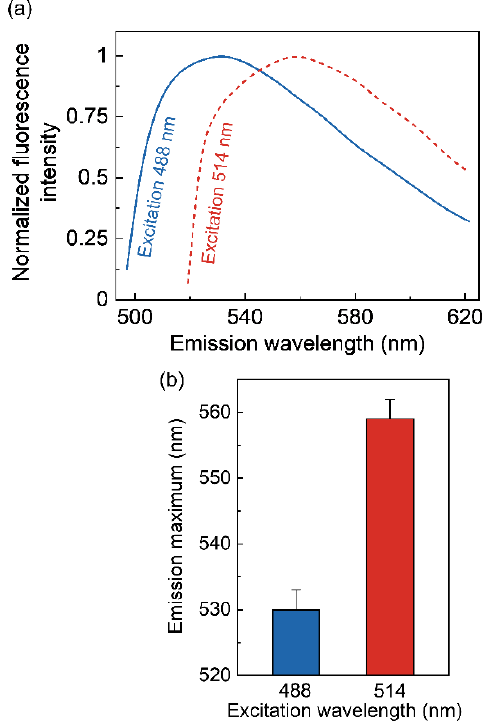
Figure 7. ( a ) Representative fluorescence emission spectra of NBD-serotonin analog I bound to the serotonin 1A receptor expressed in CHO-K1 cells at different excitation wavelengths. The excitation wavelengths were 488 (—) and 514 (- - -) nm. All spectra are intensity-normalized at the emission maximum. The concentration of NBD-serotonin analog I was 7 μM. A Zeiss LSM 880 inverted spectral imaging confocal microscope with a multichannel spectral detector was used to construct pixel-by-pixel fluorescence emission spectra from the confocal images. ( b ) Effect of changing excitation wavelength on the wavelength of maximum emission for NBD-serotonin analog I. Data represent means ± SE of at least 35 different fields from three independent experiments. See Materials and Methods for other details.